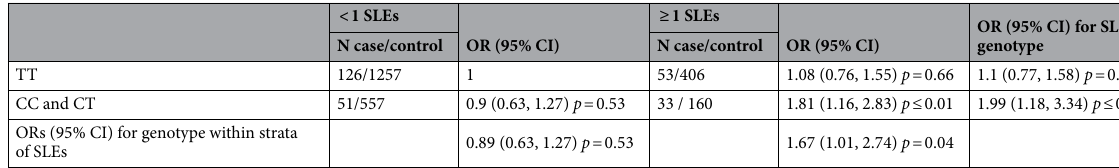
OR (95% CI) for SLE within strata of